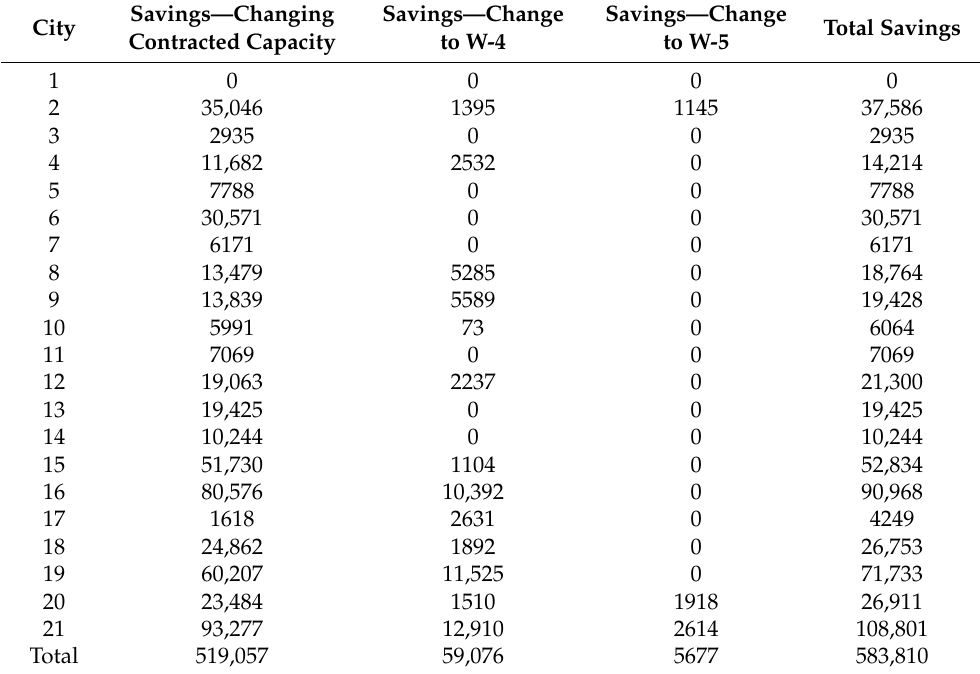
Table 4. Gas distribution costs analysis—results